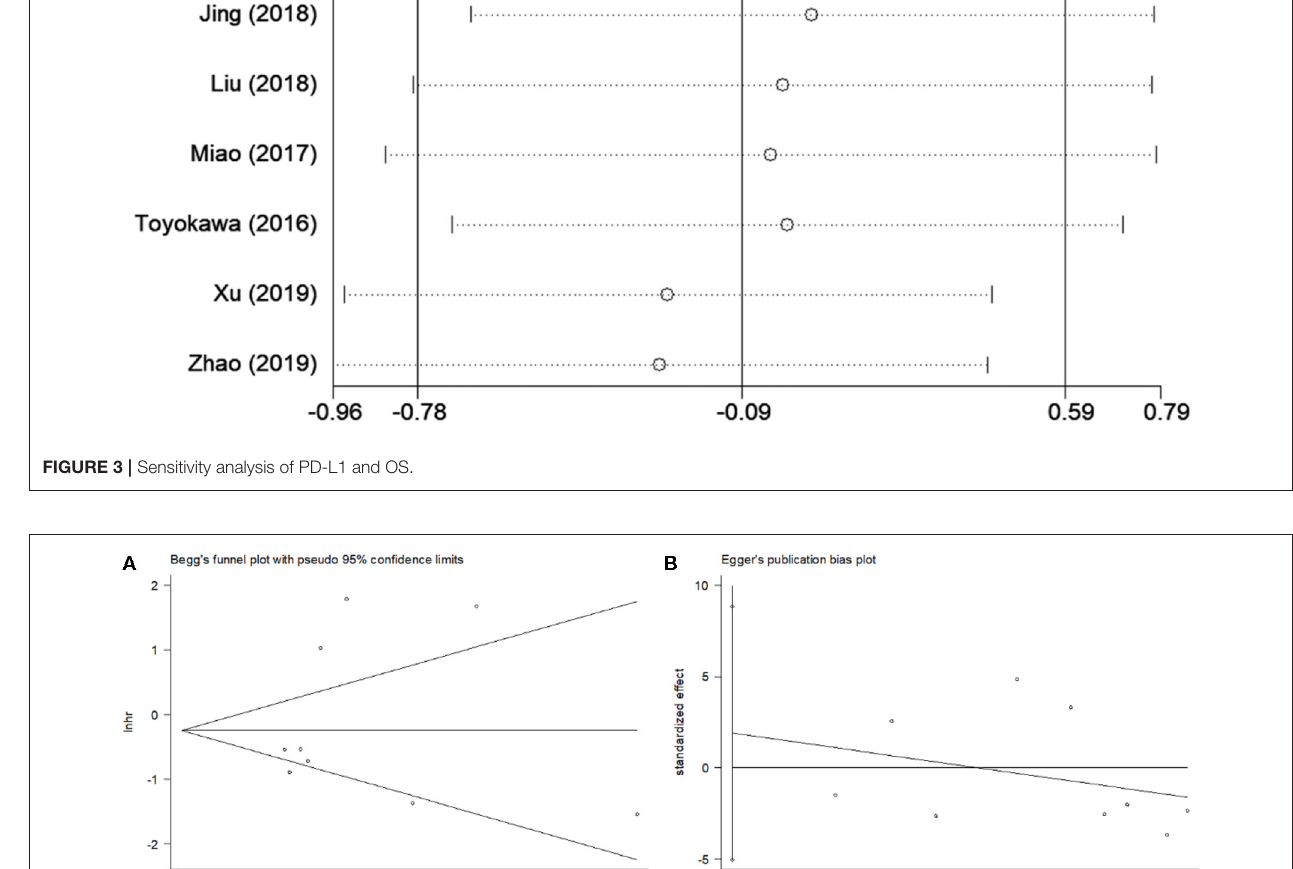
Frontiers in Oncology |